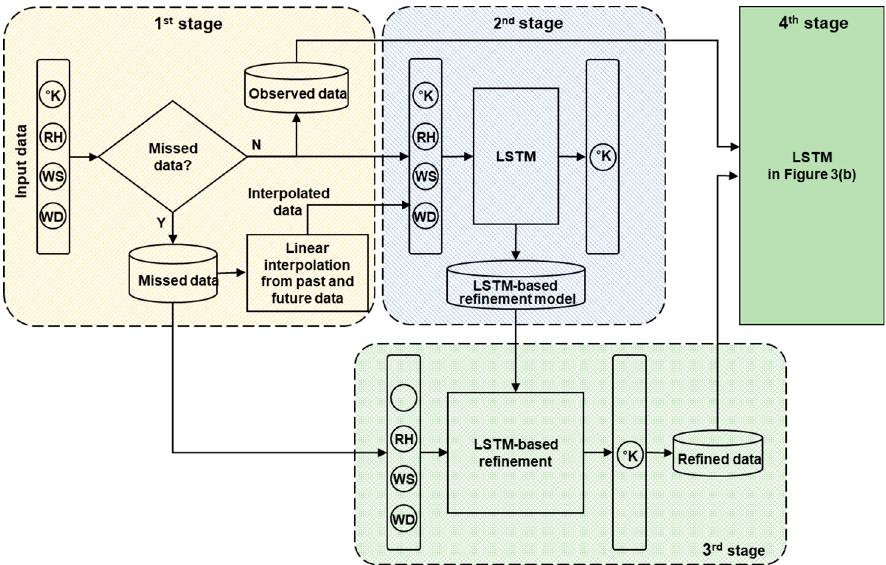
Figure 4. Architecture of the proposed LSTM-based temperature prediction model with a missing data refinement function incorporated.